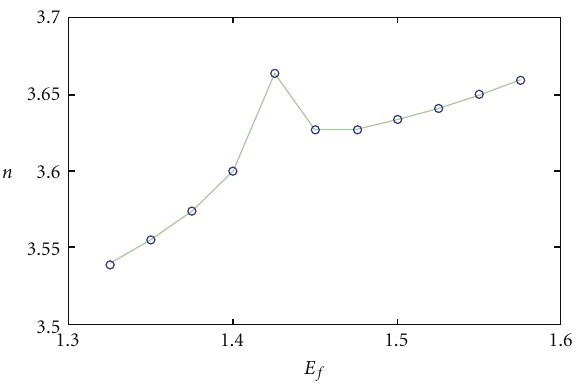
Figure 3: The refraction index of the cells with quantum wells depending on the photon